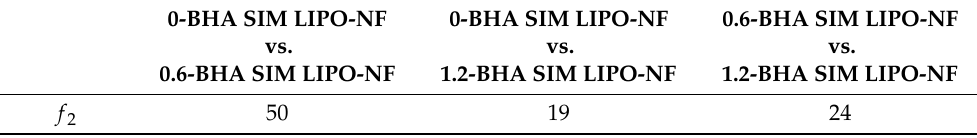
Figure 4. SIM release profiles from the nanofibers with embedded liposomes under sink conditions expressed as % of SIM released over time. The data represent the average values ± SD ( n = 3). Table 4. Similarity factor ( f 2 ) of the SIM release profiles from the three formulations under sink